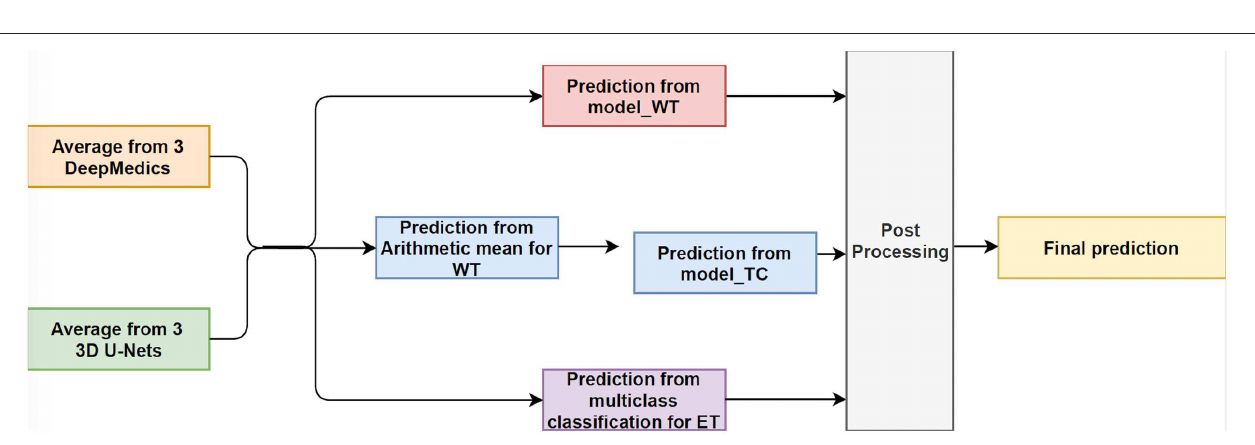
FIGURE 6 | The training workflow of two-level binary classification approach.